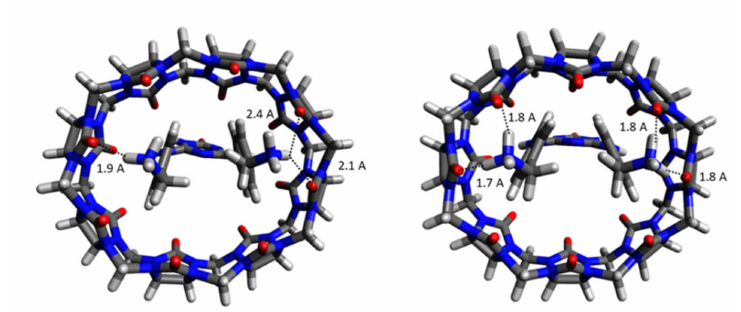
Figure 4. Ligand G0 inside the CB[8] receptor. Left: X-ray structure of co-crystallized complex. Right: Top-ranked ligand-receptor complex from conformational searches and ranking according to Gibbs free